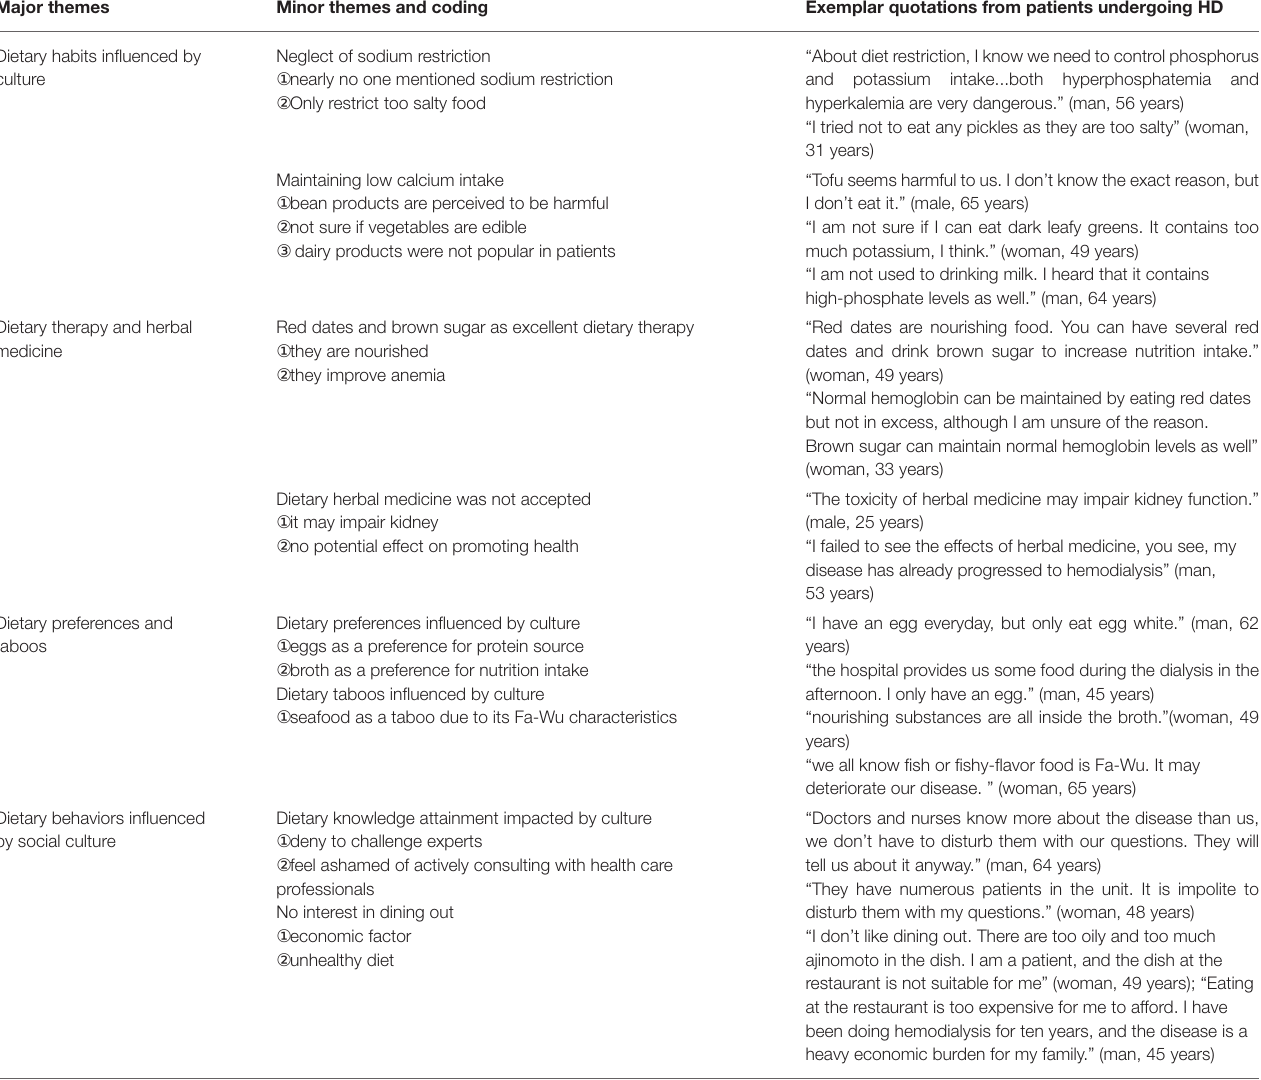
TABLE 2 | Quotations about diet influenced by culture in patients undergoing